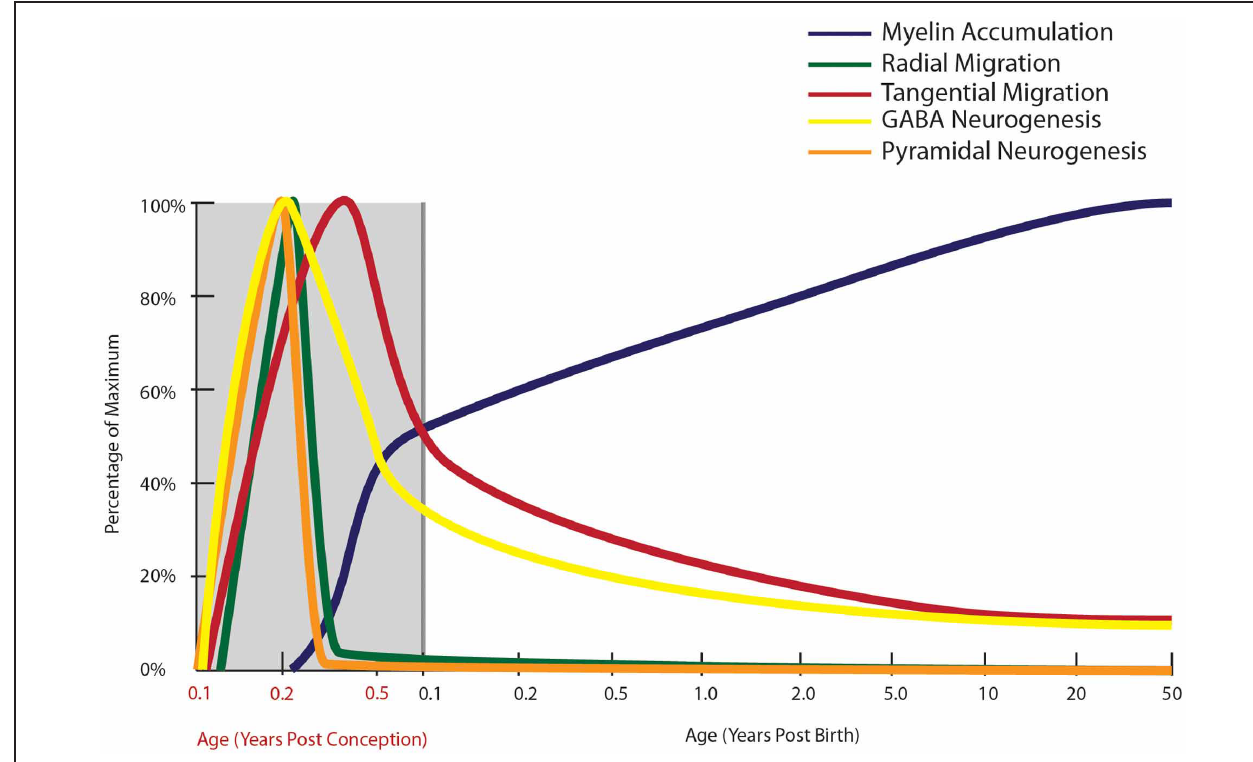
FIGURE 2 | Normal developmental trajectory of neurogenesis, neuronal migration, and myelination in the human. Neurogenesis and the subsequent migration of neurons to the cortex begin within a few weeks of gestation in the human (Zecevic et al., 2011). Pyramidal neurogenesis and migration of these cells to the cortex occurs by radial migration and is completed by mid-gestation (Nadarajah and Parnavelas, 2002), while genesis and migration of